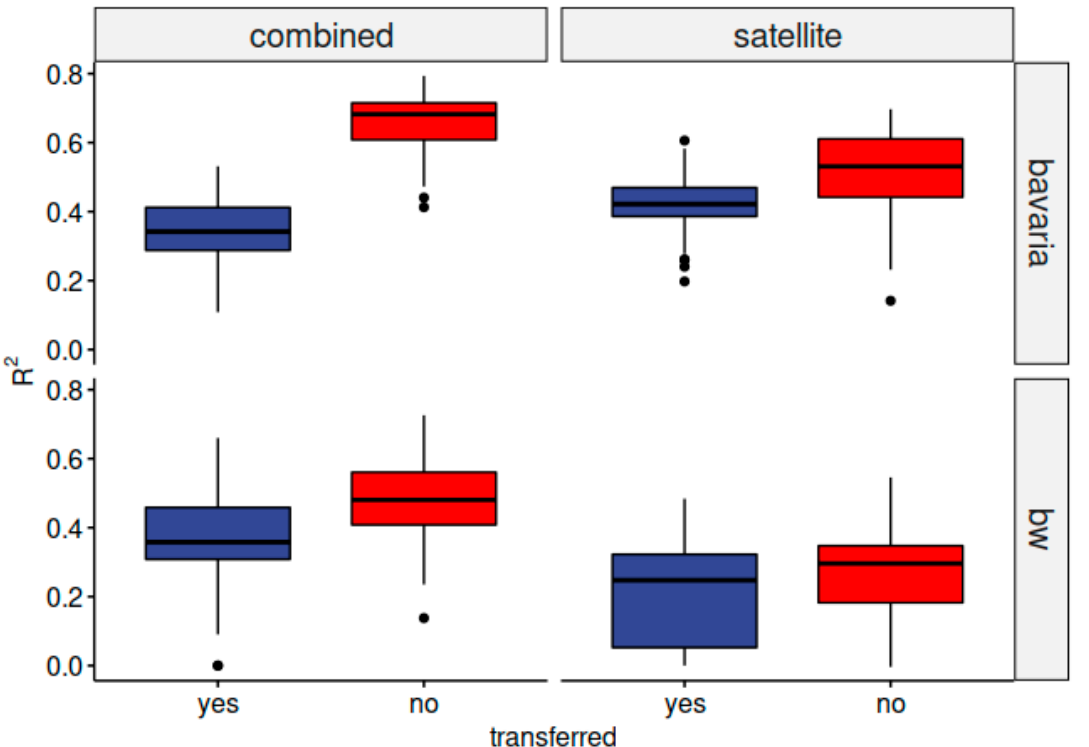
Figure 6. Comparison ( R 2 ) of combined and satellite models before (red) and after (blue) the models were transferred and tested with the samples of the other state. Black dots indicate outliers.